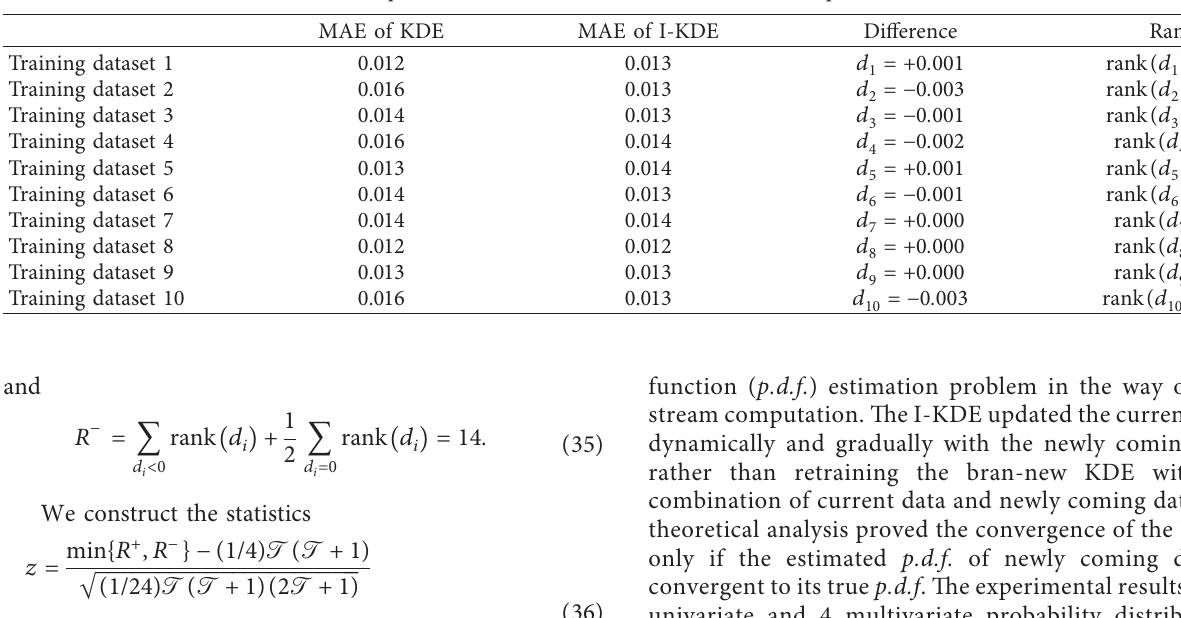
Table 3: The comparison of MAE for the KDE and I-KDE on exponential